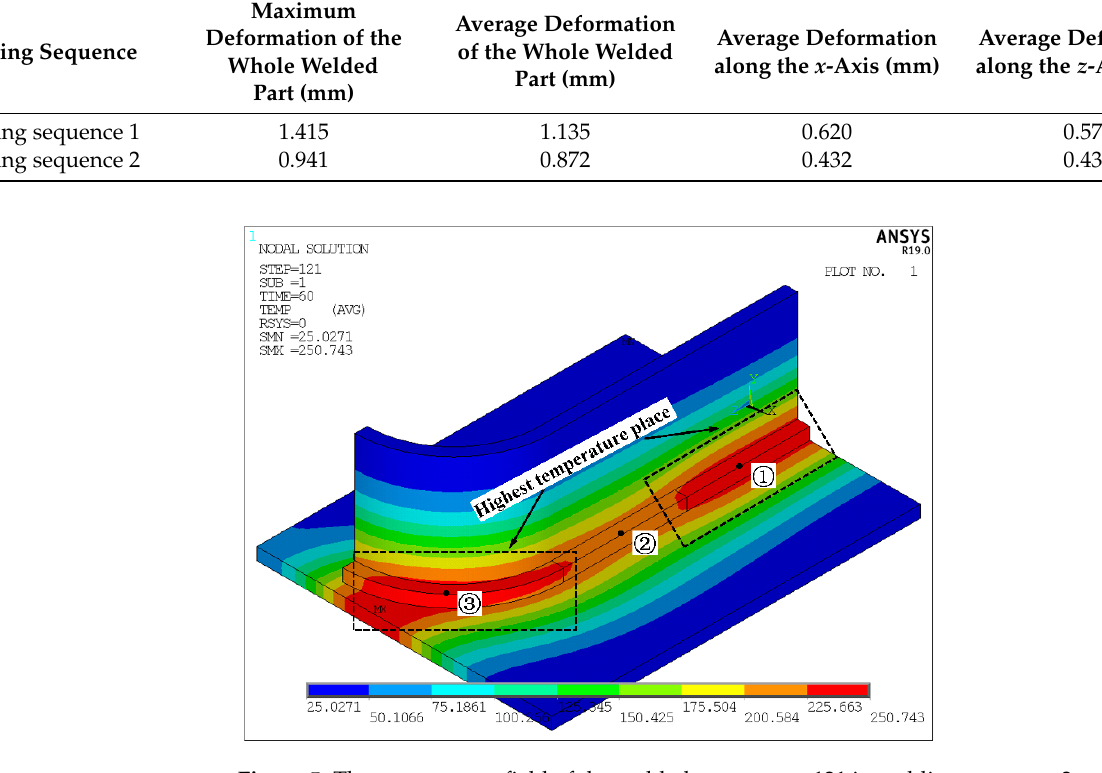
Figure 5. The temperature field of the welded part at step 121 in welding sequence 2.